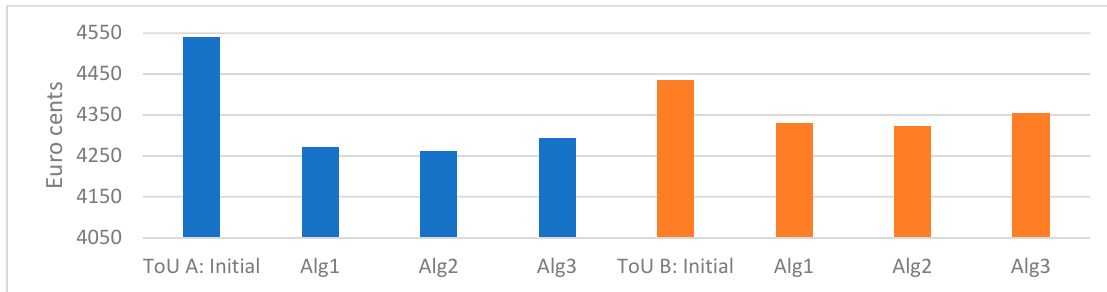
Figure 12. Daily electricity payment.